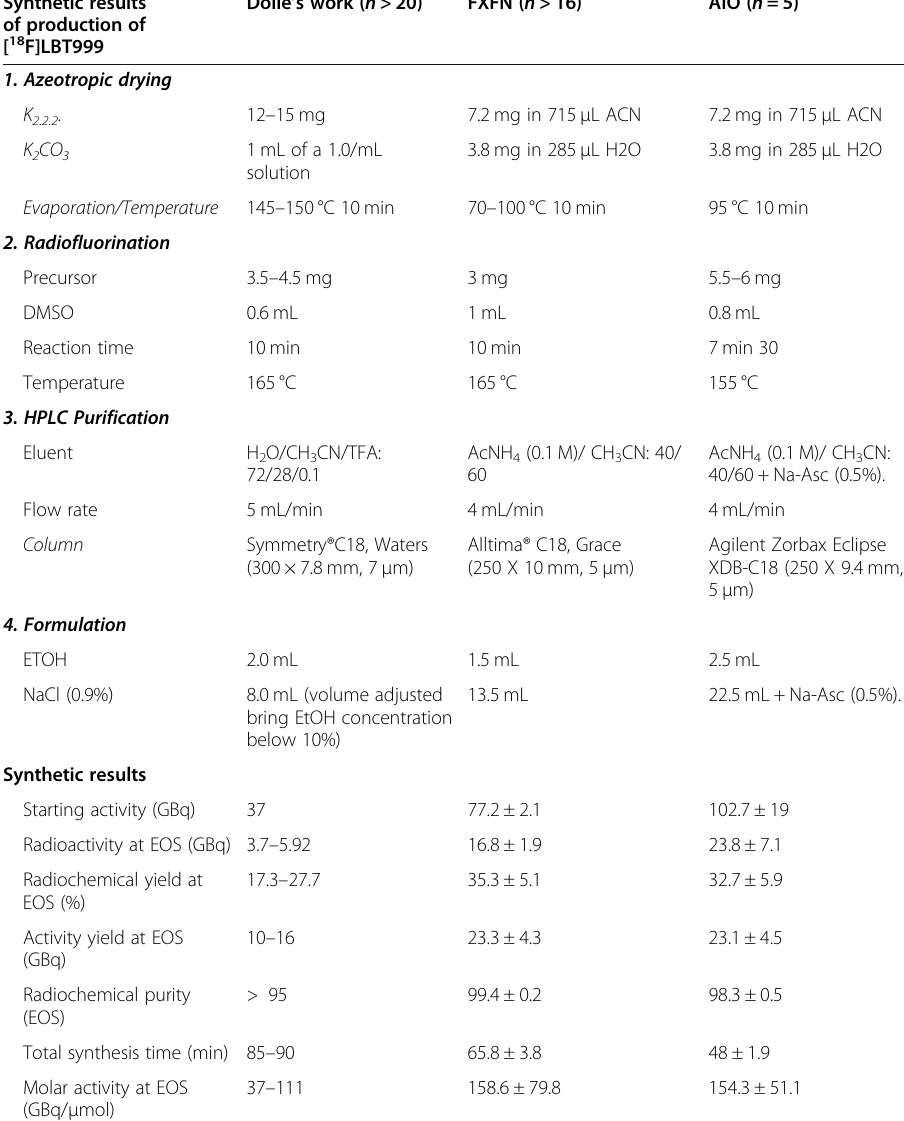
Table 2 Comparison of the main steps in the preparation of [ 18 F]LBT999 on TRACERlab FXFN and AIO modules and synthetic results compared to the initial work by Dollé ’ s group (Dolle et al., 2007) Synthetic results of production